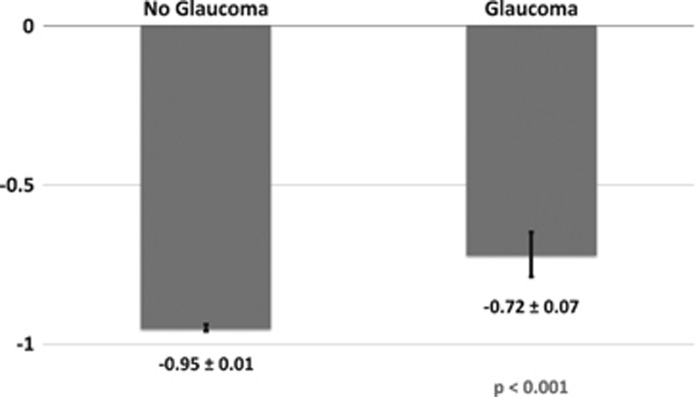
Comparison of Townsend deprivation index between individuals reporting a diagnosis of glaucoma vs those who do not (mean Townsend deprivation index±SE). Participants reporting glaucoma were significantly more likely to have a less-negative Townsend deprivation index score (P<0.001). This indicates that both groups are less deprived than the UK average (index=0, scores>0 indicate relative deprivation), but those reporting a diagnosis of glaucoma were less likely to be as affluent as those without disease.